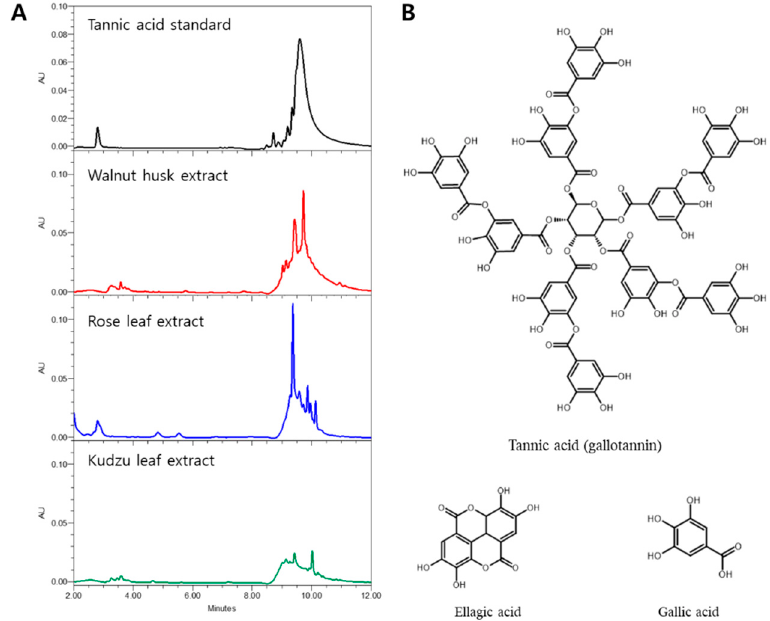
Figure 3. HPLC chromatograms of standard tannic acid and extracts of walnut husk, rose leaf, and kudzu leaf detected at 280 nm ( A ). Structures of major hydrolysable tannins in walnut husk and rose leaf extracts ( B ).